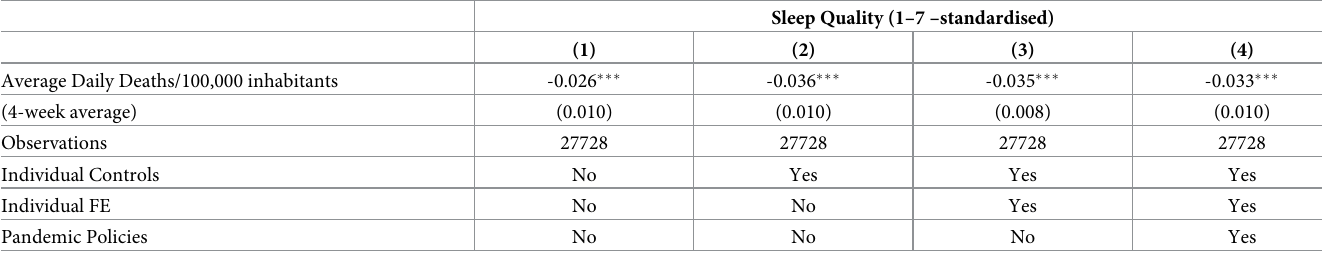
Table 2. Sleep quality and COVID-19 deaths–pooled and panel